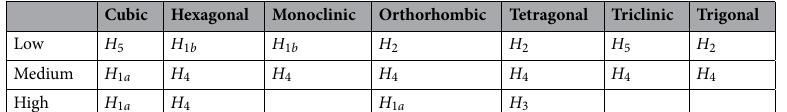
Table 6. The Classic Calculator considering crystal system and density simultaneously (CLA 2 ). Materials are classified by density ( ρ ) as low ( ρ < 4 g/cm 3 cm